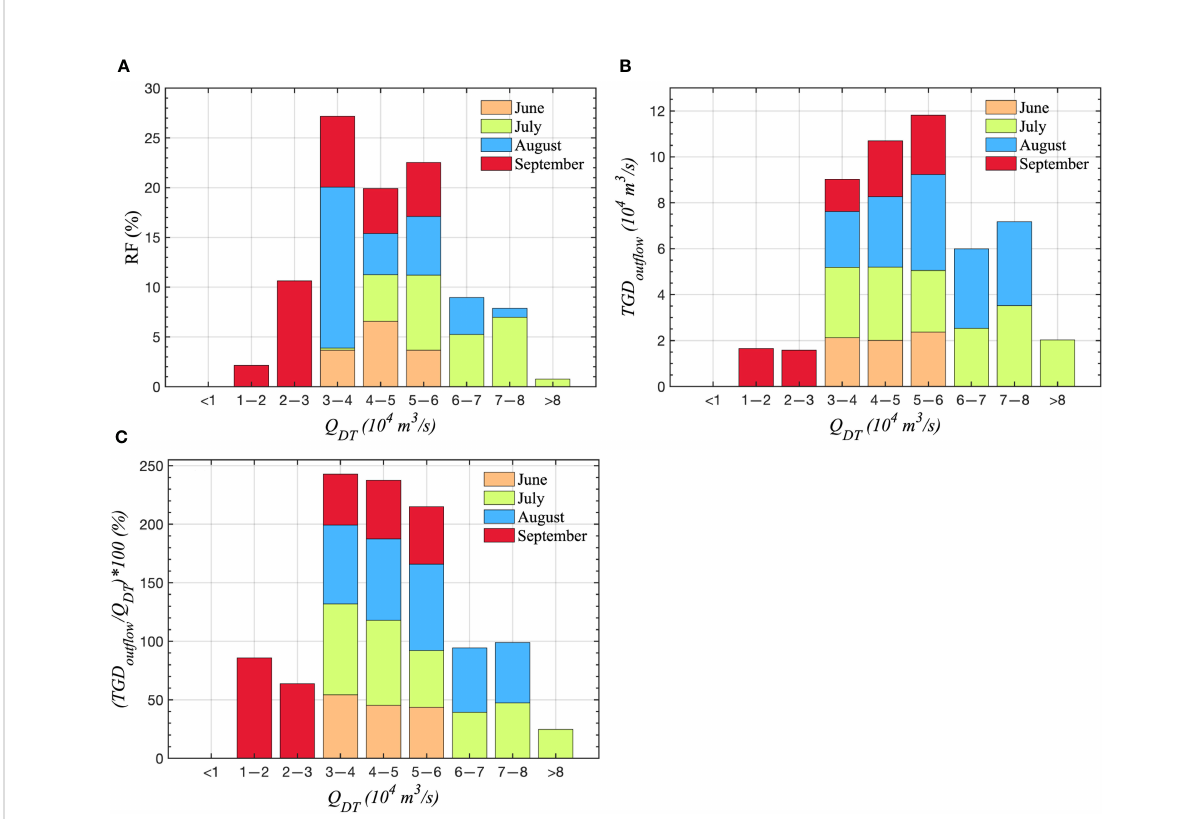
FIGURE 8 Grouped distributions of TGD out fl ow varied with the DT discharge ( Q DT ) during the wet season (June – September). (A) Relative frequency ( RF ) of TGD out fl ow; (B) Grouped TGD out fl ow in each Q DT class; (C) The proportions of TGD out fl ow in each Q DT class.